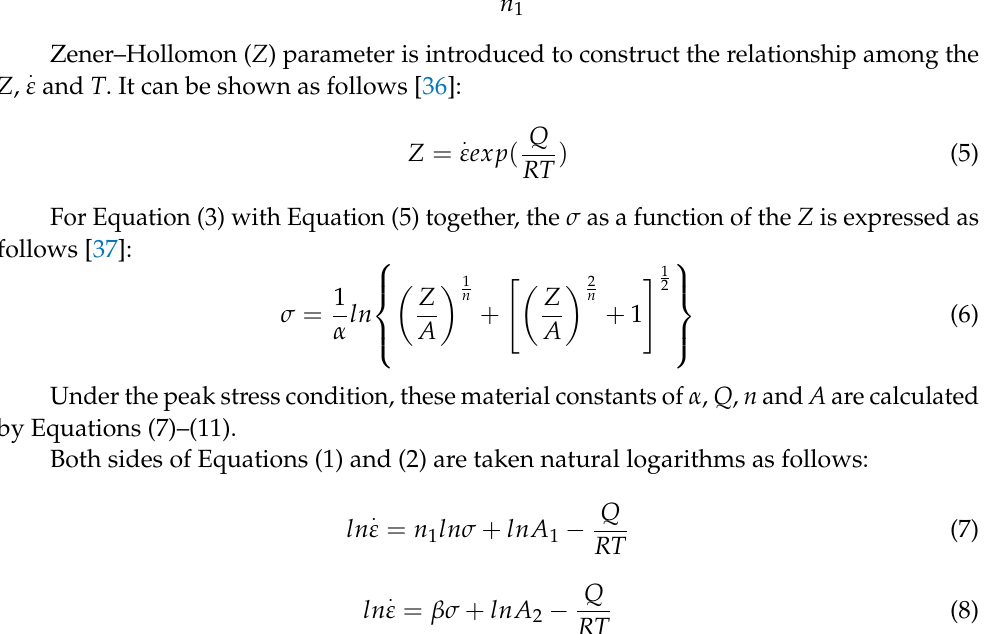
. . ε − ln σ and ln ε − σ , respectively. The